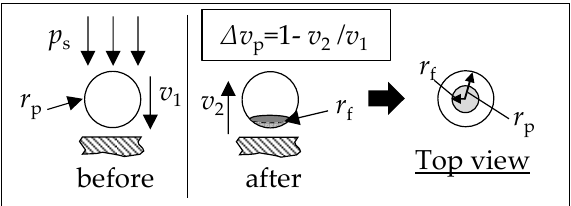
Figure 2. Scheme of the particle-oriented peening process, including all considered variables.